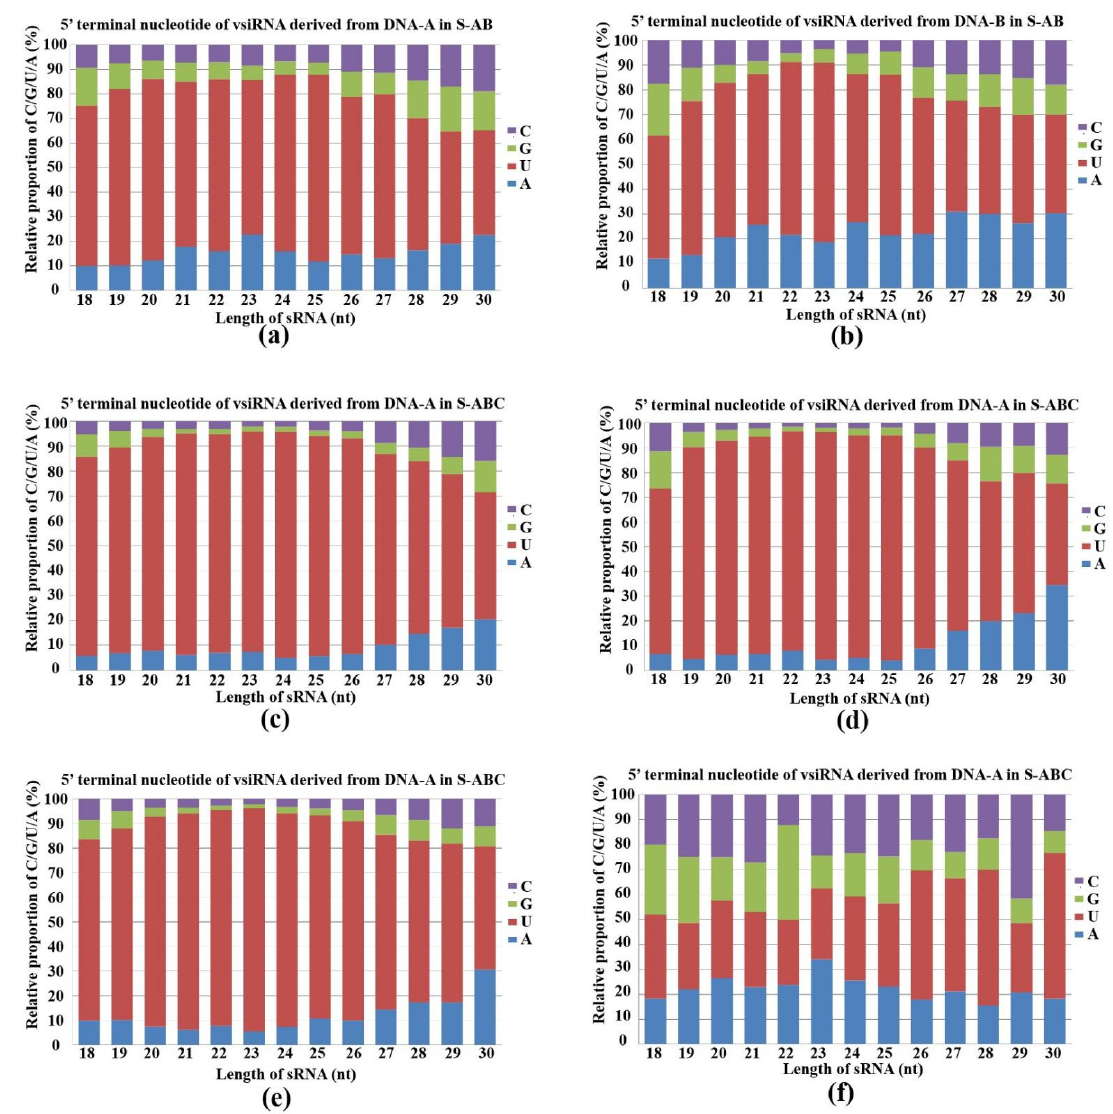
Figure 4. Composition of the 5 ′ -terminal nucleotide among vsiRNAs. Composition of the 5 ′ -terminal nucleotide of 18–30-nt siRNA derived from ( a ) DNA-A in S-AB, ( b ) DNA-B in S-AB, ( c ) DNA-A in S-ABC, ( d ) DNA-B in S-ABC, ( e ) DNA-C in S-ABC, ( f ) F. graminearum genome in S-S. The x-axis represents vsiRNA length, ranging from 18- to 30-nt and the y-axis shows the composition of G/C/A/U at 5 ′ -terminal nucleotides. S-S (virus-free strain), S-AB (S-S strain infected with DNA-A and DNA-B segments of FgGMTV1), S-ABC (S-S strain infected with DNA-A, DNA-B and DNA-C segments of FgGMTV1).